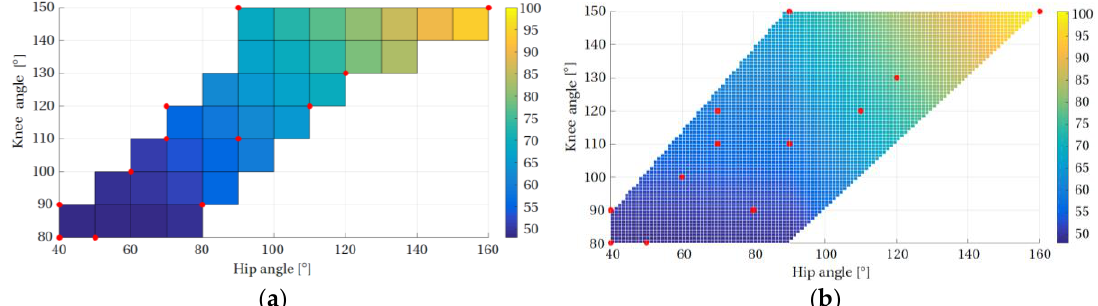
Figure 3. Percentage C D A relative to the reference position at different knee and hip angles measured on one test subject. The color bar shows the percentage C D A and the measured points from the experiment are presented with red dots. ( a ) Measurement results from the experiment and ( b ) the resulting regression